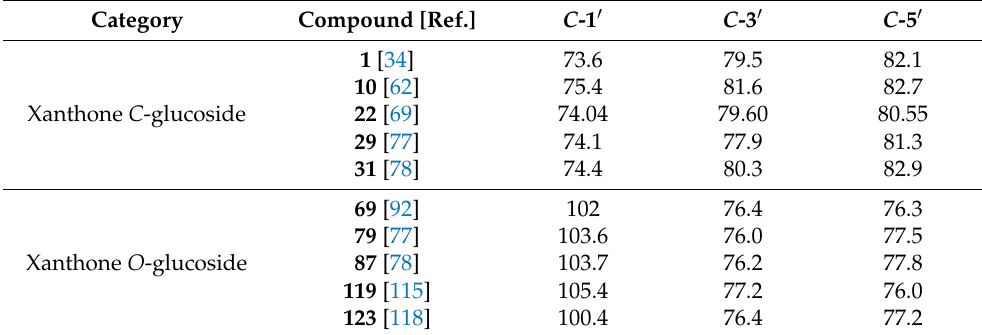
Table 5. 13 C NMR data of typical